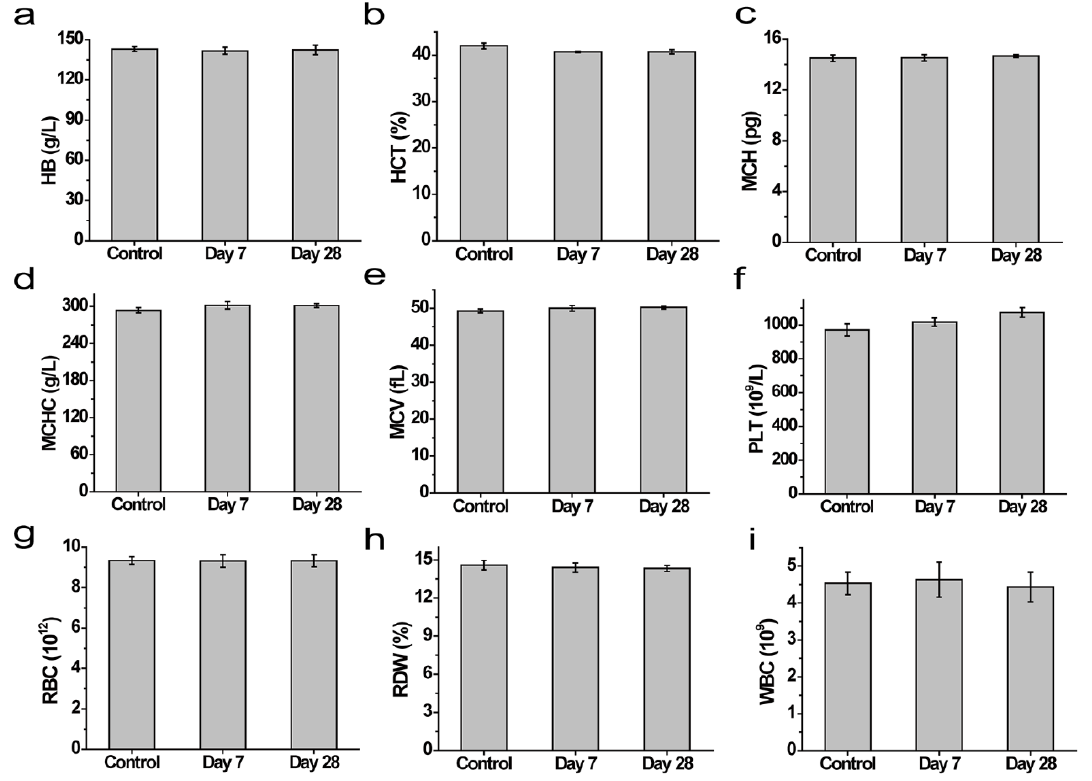
Figure 6. ( a – i ) Routine blood results for different days in mice subcutaneously embedded in hydrogel or blank (control).